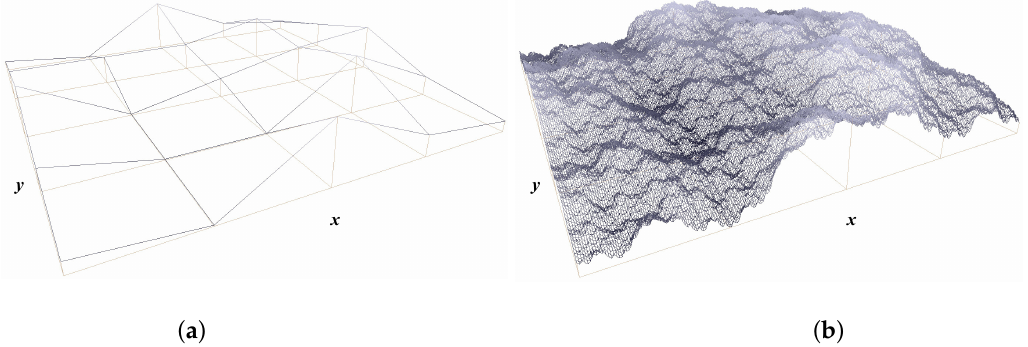
Figure 7. ( a ) The surface constructed with the original set of data. ( b ) The fractal interpolation surface. Table 1. The original data for fractal interpolating surface (a) of Condition β and (b) of Condition γ